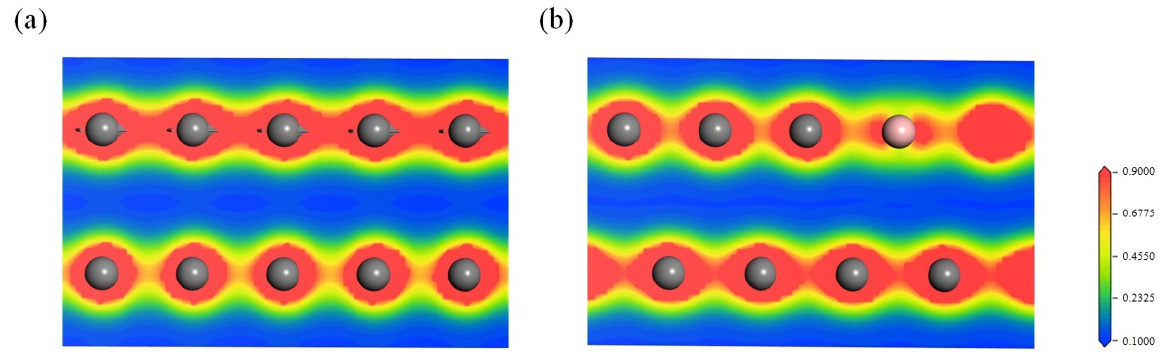
Figure 6. Charge density diagram within the (010) plane of ( a ) graphite and ( b ) boron-doped graph- ite across the boron atoms. Carbon: dark grey, boron: pink.